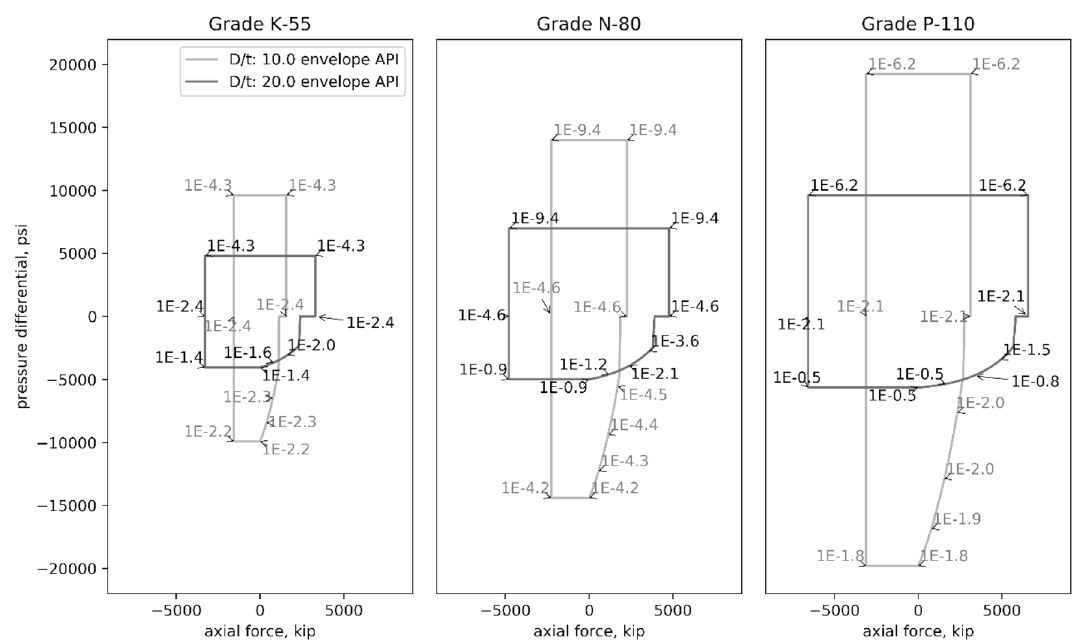
Fig. 10 Probabilities of exceeding SLS at API design envelope for grades K55, N80 and P110, with D ∕ t 10.0 and 20.0